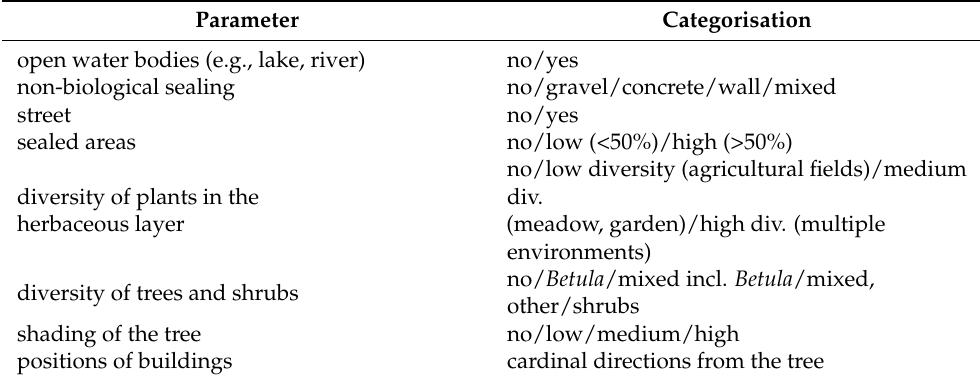
Table 1. Parameters characterising the surroundings of the